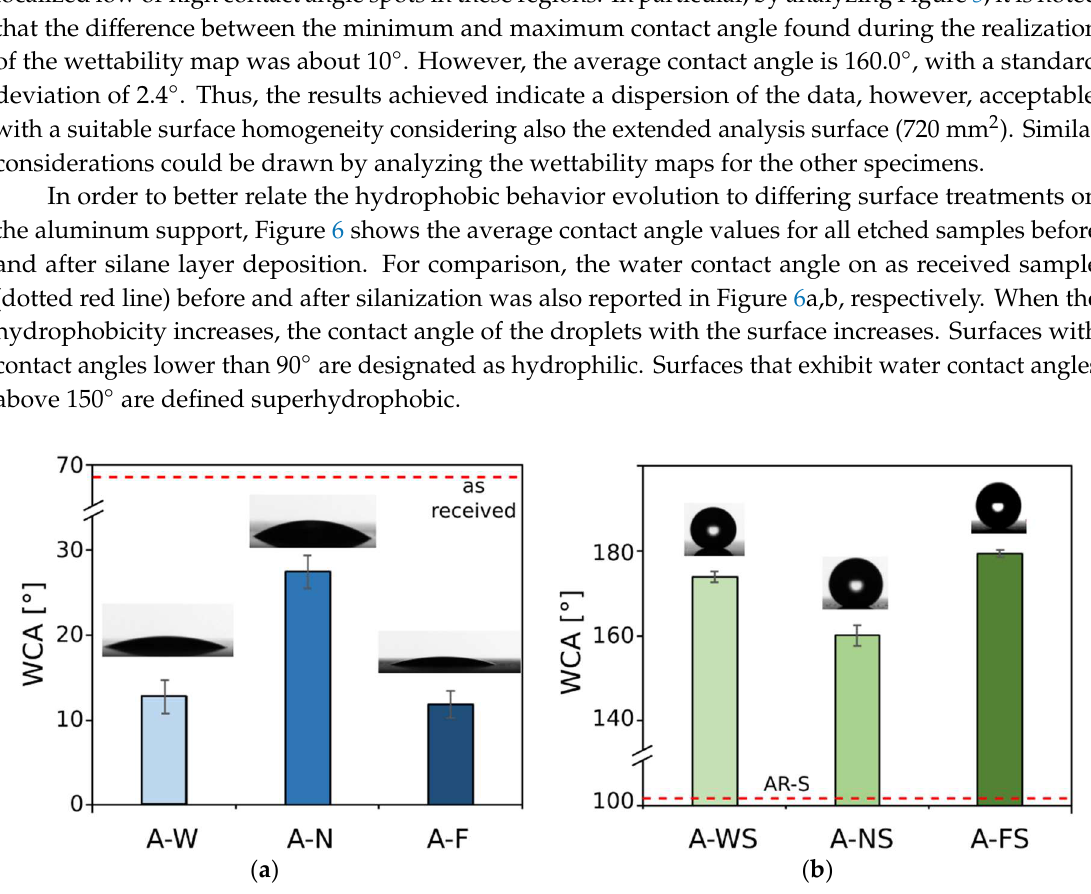
Figure 6. Contact angle for distilled water on surface treated and untreated aluminum alloy substrate ( a ) before silanization step and ( b ) after silanization dip-coating process. A dissimilar scale was used on vertical axes of the two plots to better highlight the differences between the several compared surfaces.